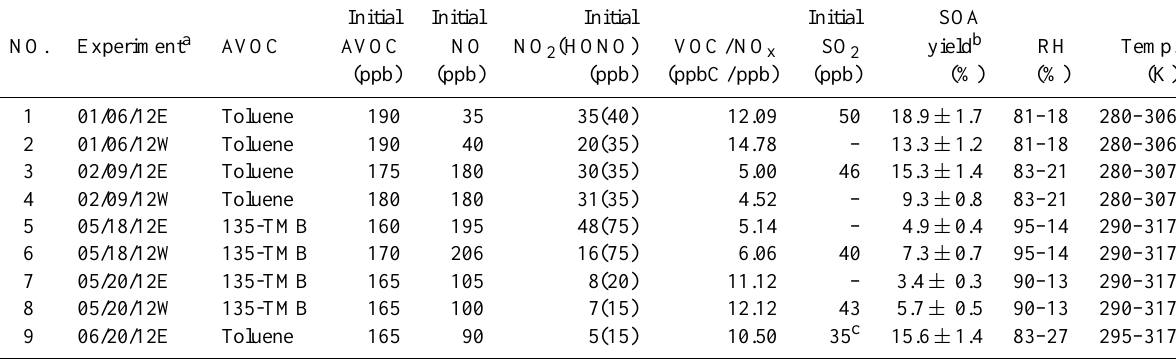
Table 1. SOA chamber experimental conditions and resulting SOA